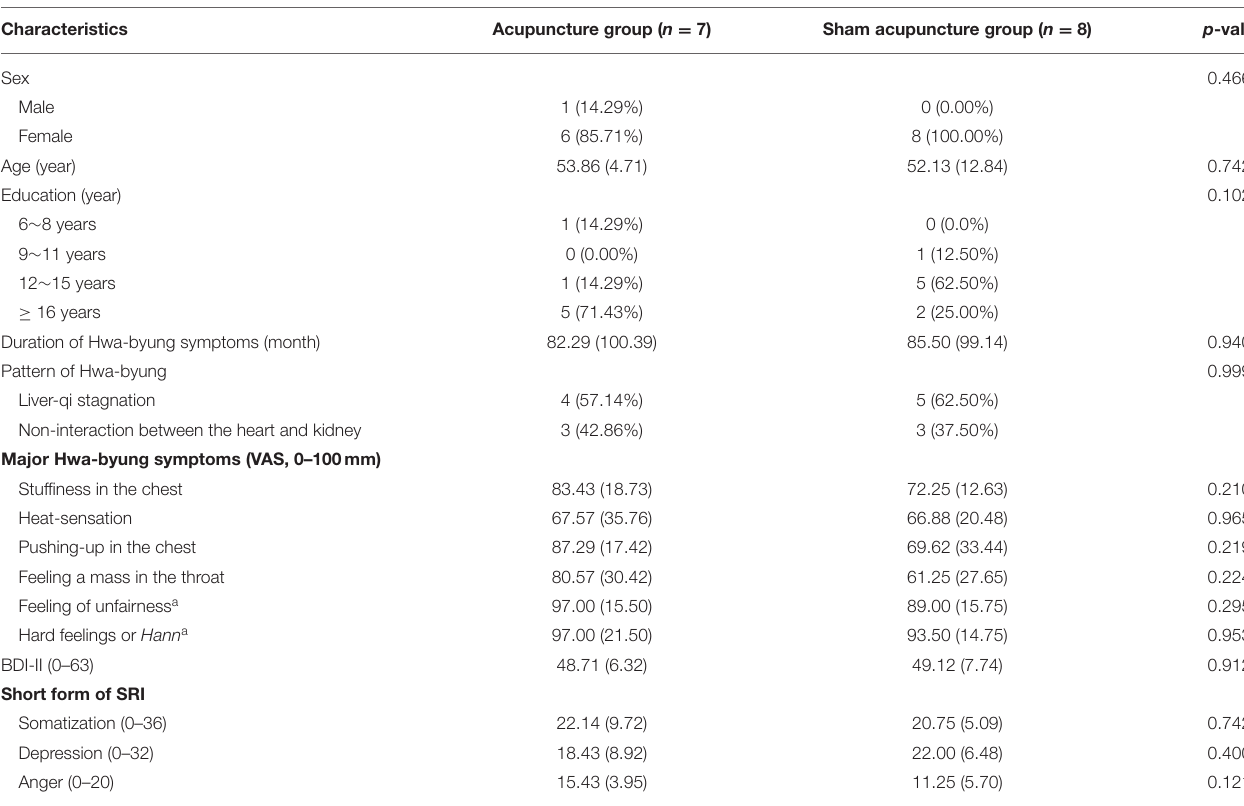
TABLE 1 | Participant baseline